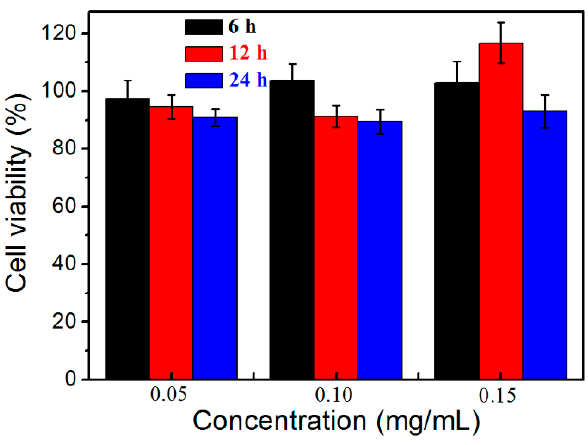
Figure 5. Cell viability of HPManEMA- co -MBA ( S4 ) at different concentrations.